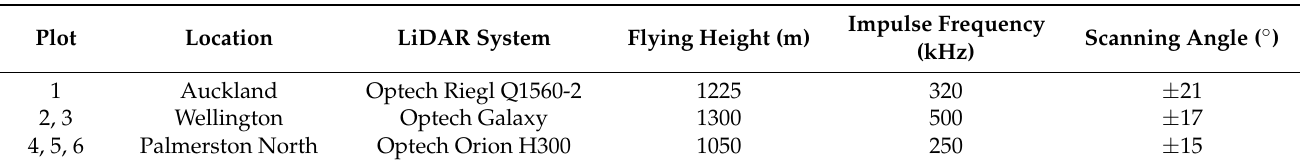
Table 1. Plot location and some information for the collection of the point clouds including LiDAR system, flying height, impulse frequency and scanning angle.